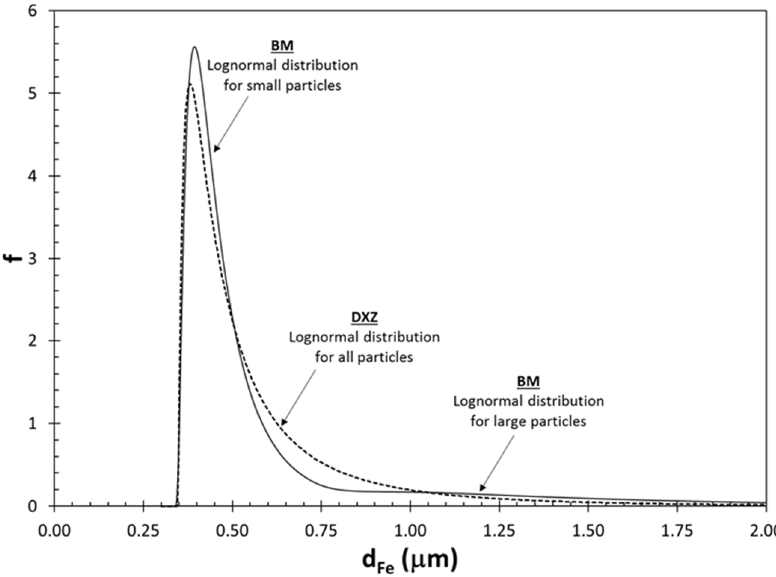
Figure 6. Fe particle size and distribution for the base material (No ‐ FSP) and DXZ zone (FSP).